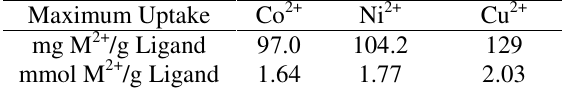
Table 2. Maximum metal uptake by